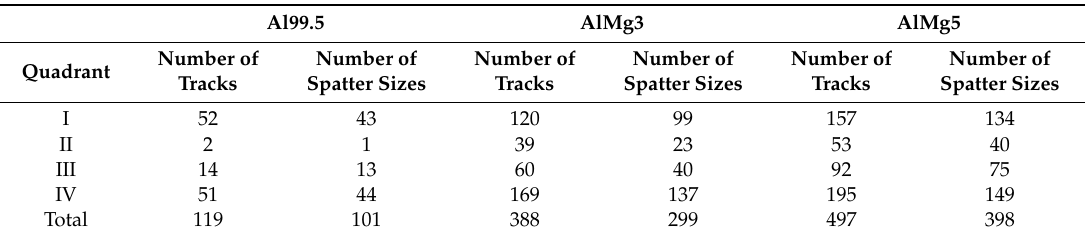
Table 2. Number of reconstructed tracks and associated spatter sizes sorted by quadrant for the evaluation of a 10.23 mm seam length (4000